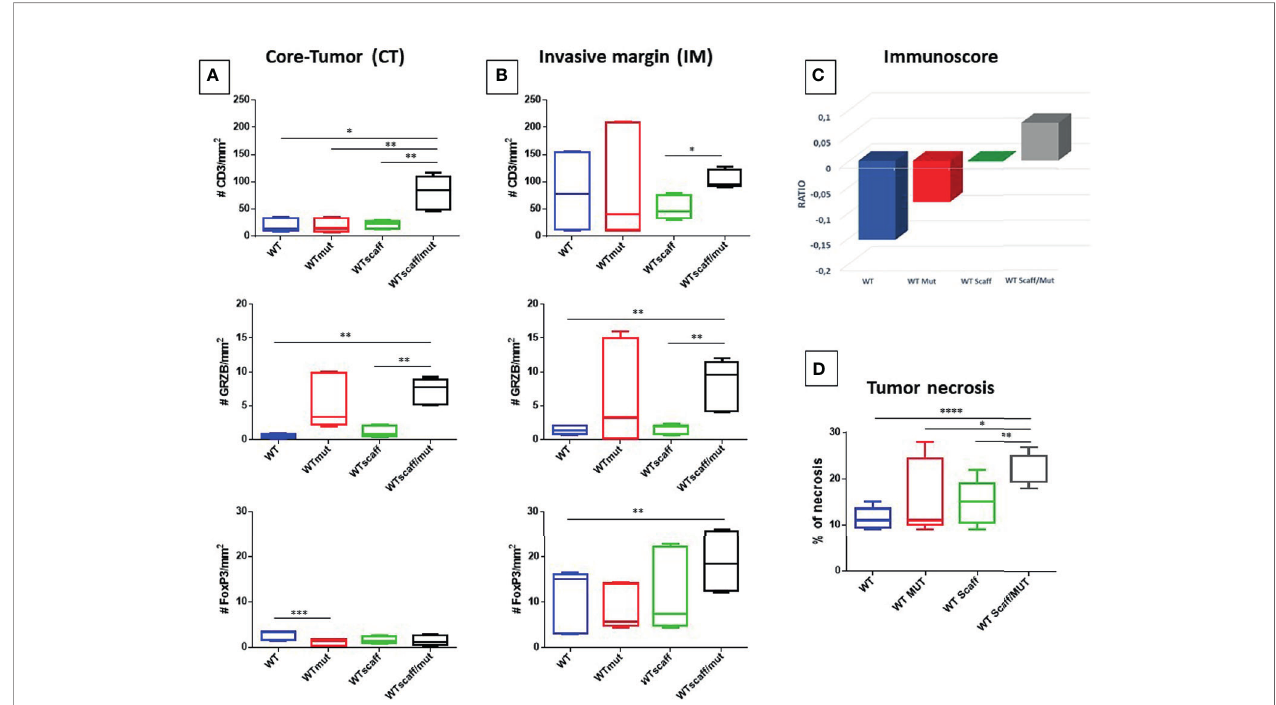
FIGURE 8 | Number of CD3 + Granzyme B + and FoxP3 + cells in fi ltrating B16F10 tumors. Cells are represented as mean with standard deviation (SD) in each experimental group. (A) CD3 + , Granzyme B + and FoxP3 + cells in CT (A) and IM (B) area by IHC are shown, respectively. (C) Cumulative evaluation of the effector cytotoxic GrzB+ and suppressive FOXP3+ T cell on total CD3+ cells. Average standard deviation of the percentage of necrosis in each experimental group is shown (D) . Statistical analysis 2way ANOVA: *p < 0.05, **p < 0.005, ***p < 0,001, ****p <